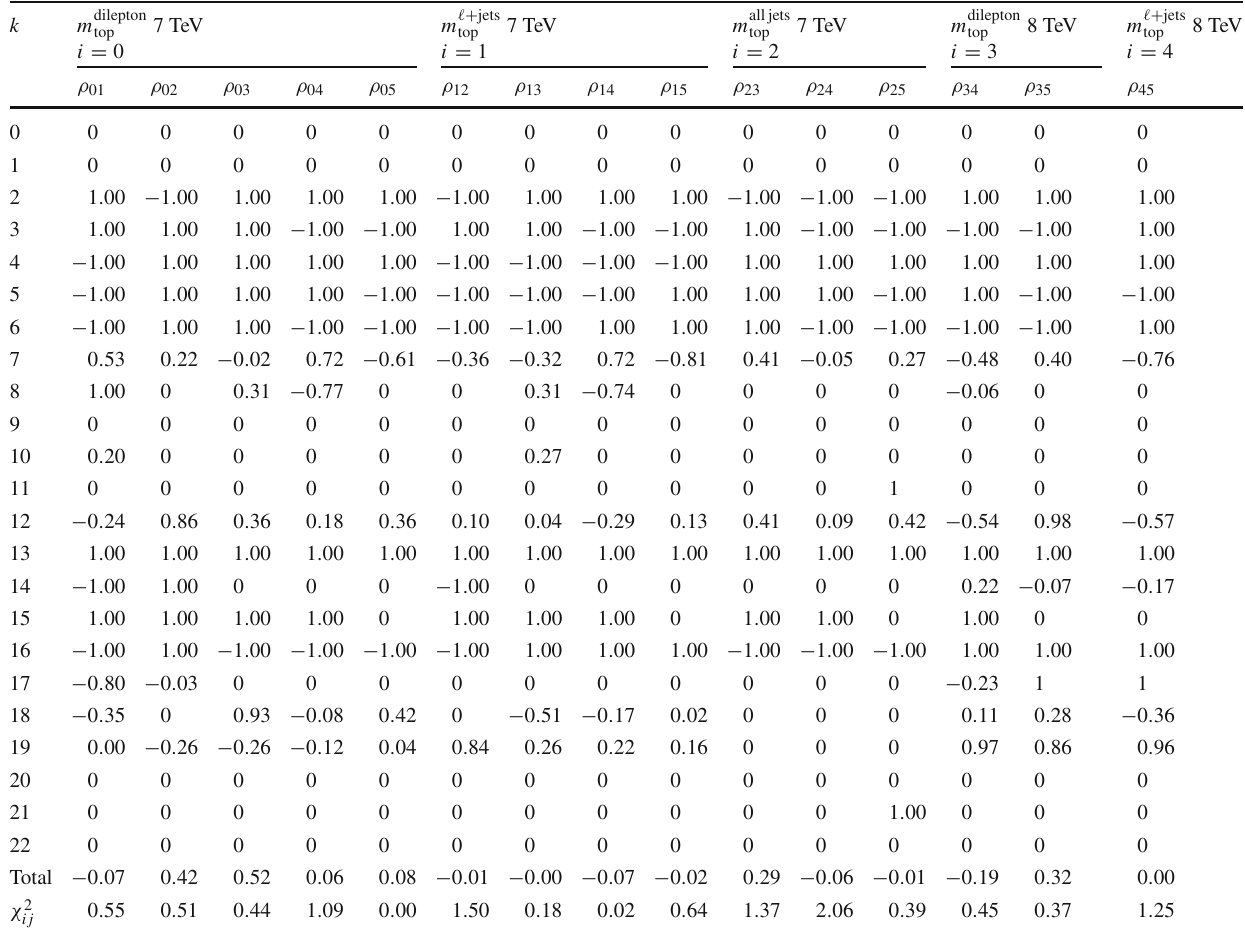
√ Table 5 The pairwise correlations ρ ijk of the six measurements s = 8 TeV. The correspondence of the indices for t ¯ t → alljets at i , j = 0 ,..., 5 of m top for each source of systematic uncertainty k = 0 ,..., 22 and the sources of systematic uncertainty are given in k = 0 ,..., 22, along with the total estimator correlations and the com- Table 4. Correlations that are assigned, or cannot be evaluated because one uncertainty in the covariance term is zero at the quoted precision, patibility of the measurements using χ 2 from Eq. (2). The indices i and √ ij are given as integer values, while evaluated correlations are shown as j are 0 for t ¯ t → dilepton at s = 7 TeV, 1 for t ¯ t → lepton + jets √ √ real s = 7 TeV, 2 for t ¯ t → alljets at s = 7 TeV, 3 for t ¯ t → dilepton at √ √ s = 8 TeV, 4 for t ¯ t → lepton + jets at s = 8 TeV, and 5 at